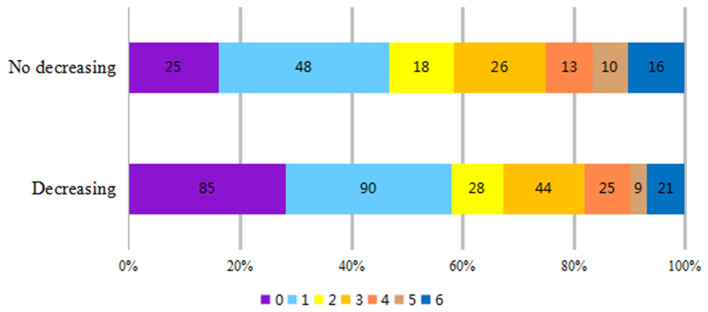
Distribution of 3 m modified Rankin Scale (mRS) after thrombolysis.